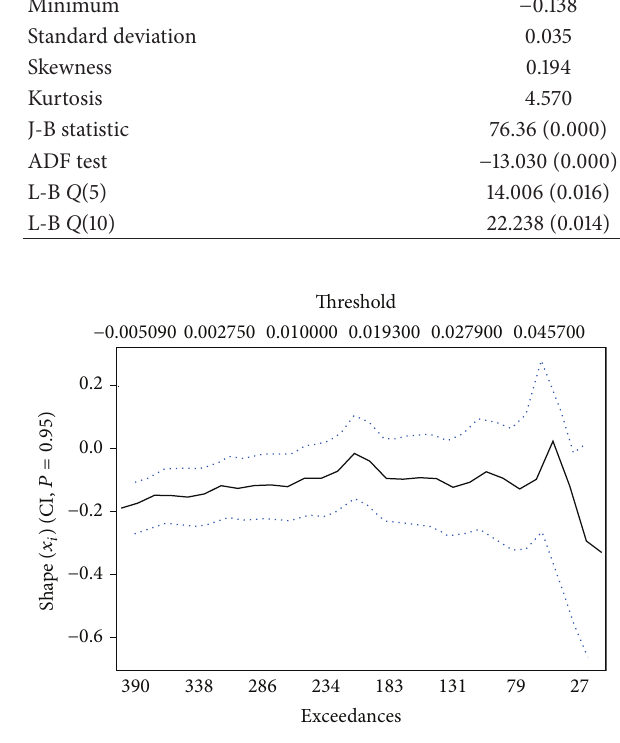
Figure 3: Estimates of shape parameter as a function of the threshold